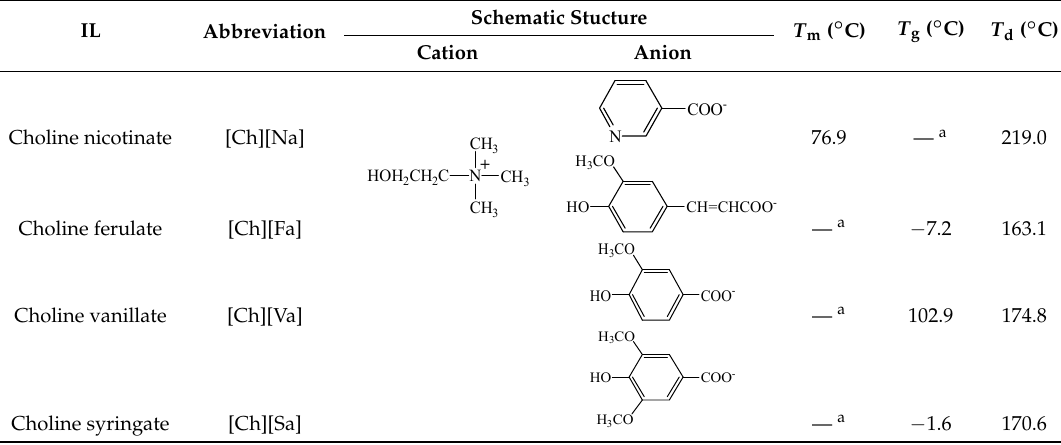
Table 1. Melting temperature ( T m ), glass transition temperature ( T g ), and thermal decomposition temperature ( T d ).